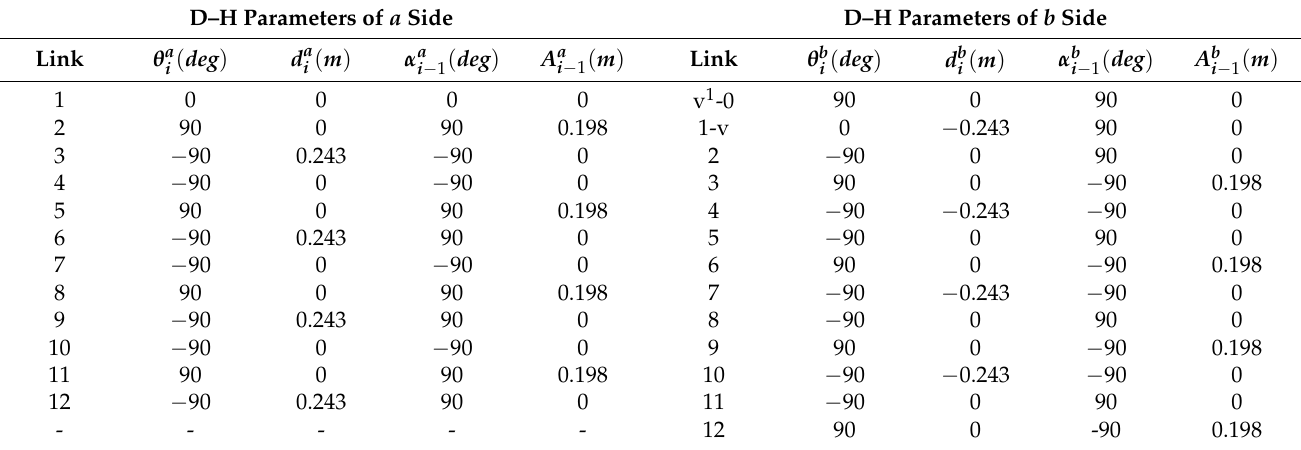
Table 1. D–H parameters of